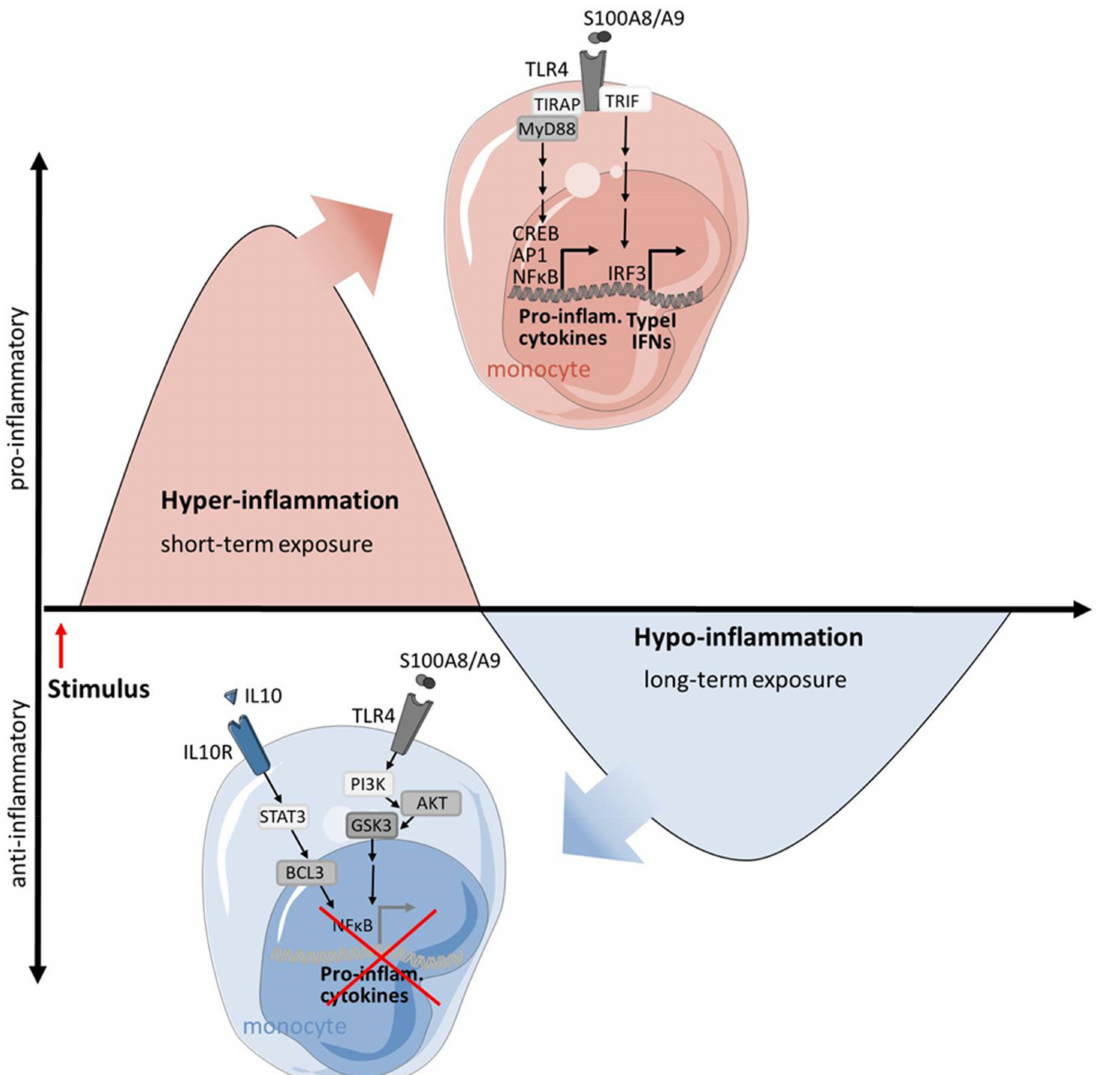
Figure 3. S100A8 and S100A9 are well known ligands of TLR4 and induce the expression of proin- flammatory cytokines and type I interferons in monocytes and macrophages. Therefore, they function as amplifiers of phagocyte activation during the early hyper-inflammatory state of SIRS. How- ever, long-term stimulation with S100A8/S100A9 has a regulatory role in promoting phagocyte hypo-responsiveness to subsequent inflammatory stimulation. It was shown that prolonged stim- ulation with low doses of S100A8 and S100A9 leads to an activation of the phosphatidylinositol 3-kinase/AKT/GSK-3 β pathway which interferes with the NF- κ B–driven expression of proinflam- matory cytokines. This inhibition of cytokine production is further enhanced by secondary IL-10 triggered activation of STAT3 and